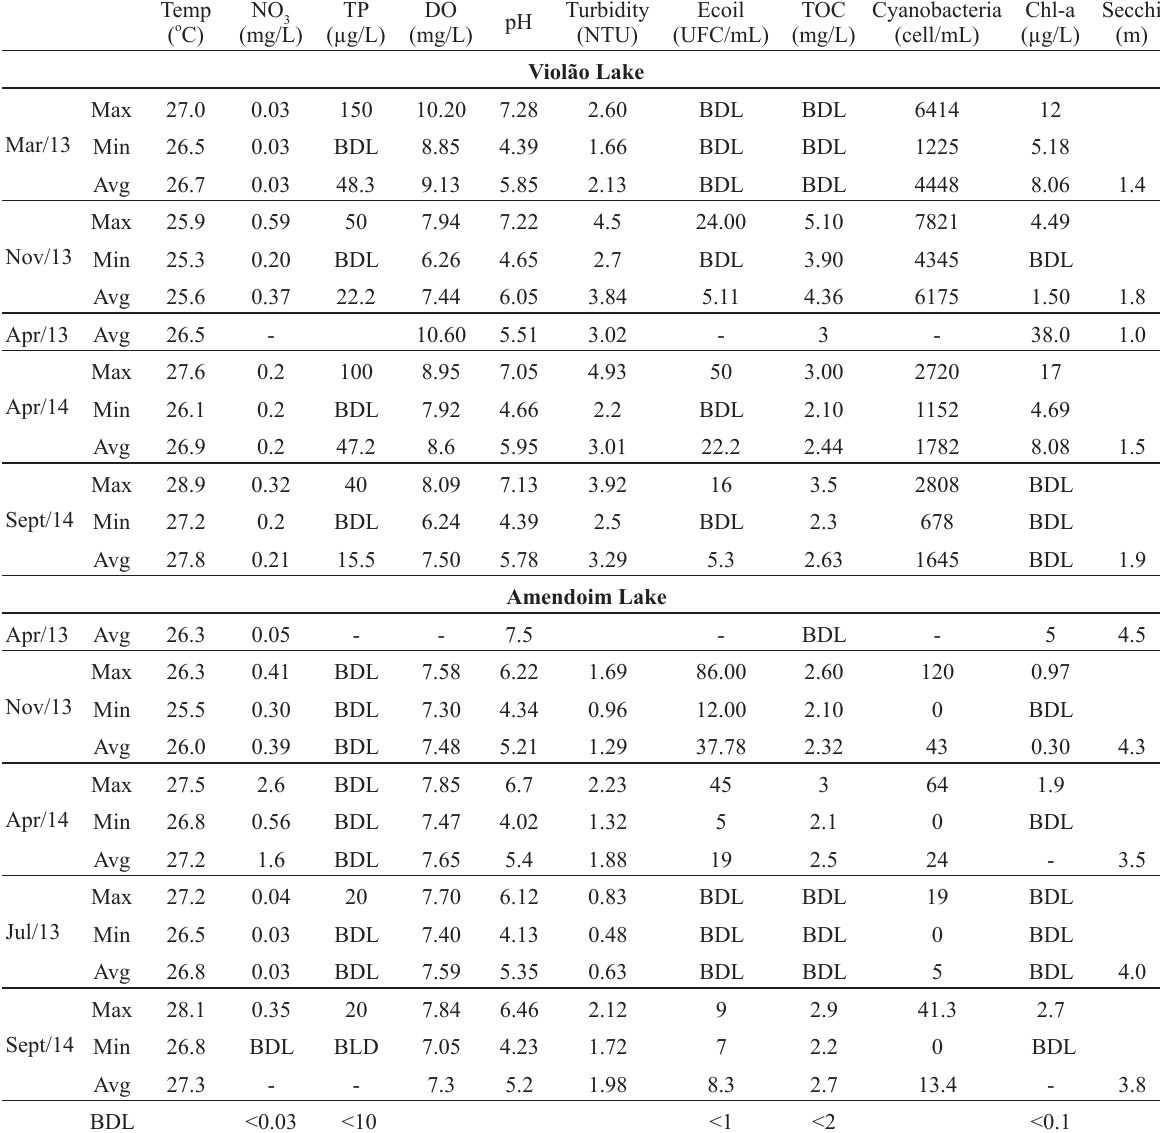
The physico-chemical and biological parameters in wet (March, April and November) and dry (July and September) period of Violão and Amendoim